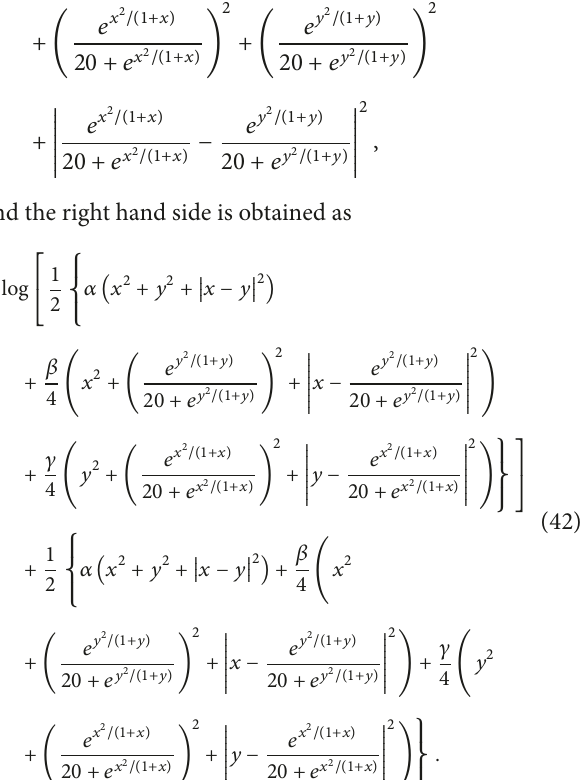
hand side function is dominating the surface representing